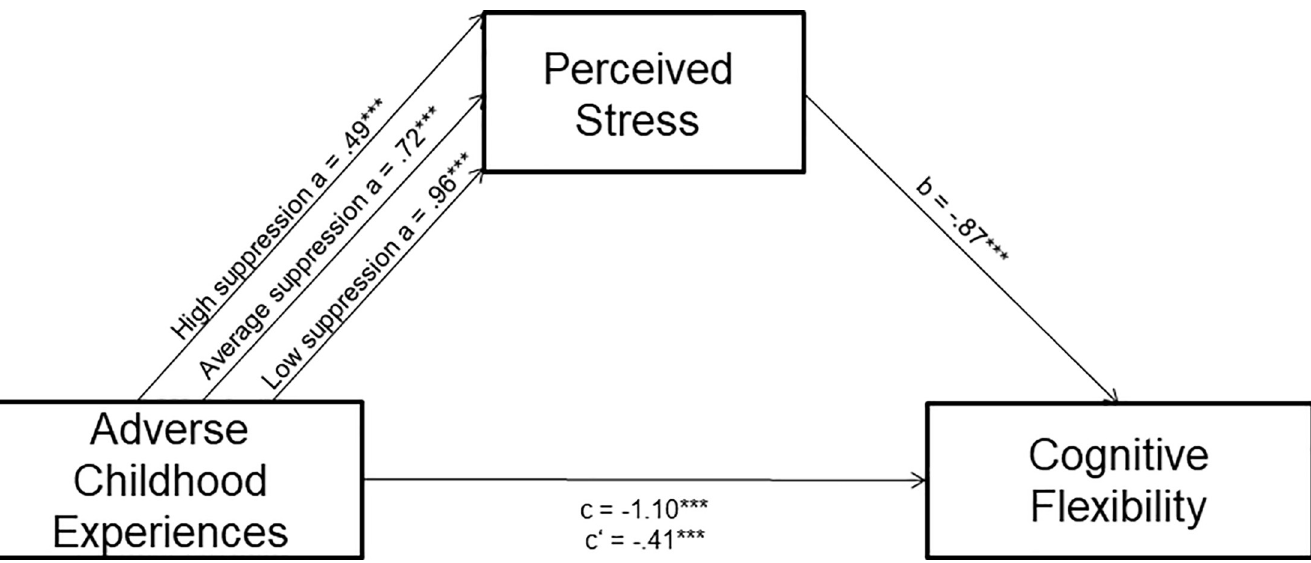
PLOS ONE | https://doi.org/10.1371/journal.pone.0235412 June 26,